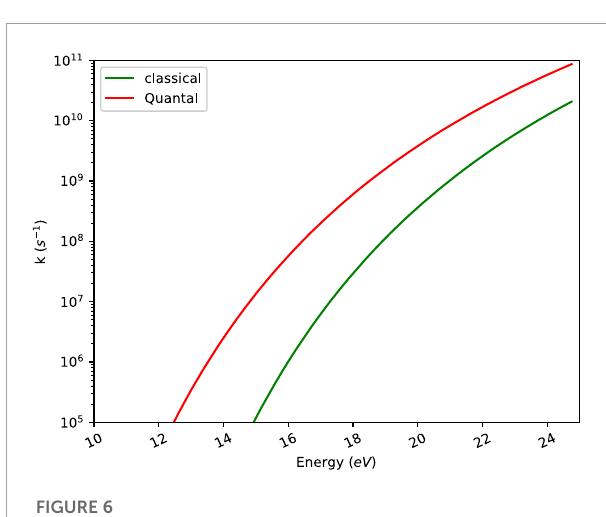
FIGURE 6 RRKM microcanonical rate constants calculated using the classical expression and direct count (Quantal) method for C 2 H 2